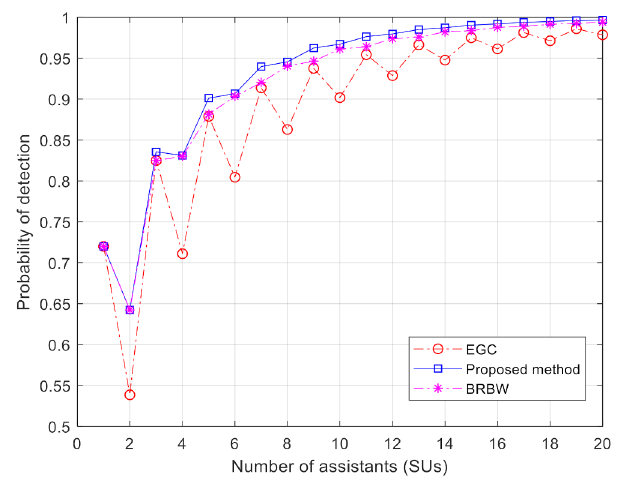
Figure 12. The change of detection probability under different number of assistants for three different algorithms.